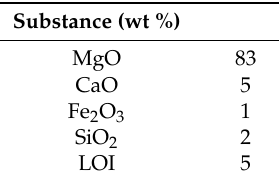
Table 1. Chemical composition of used MgO powder.